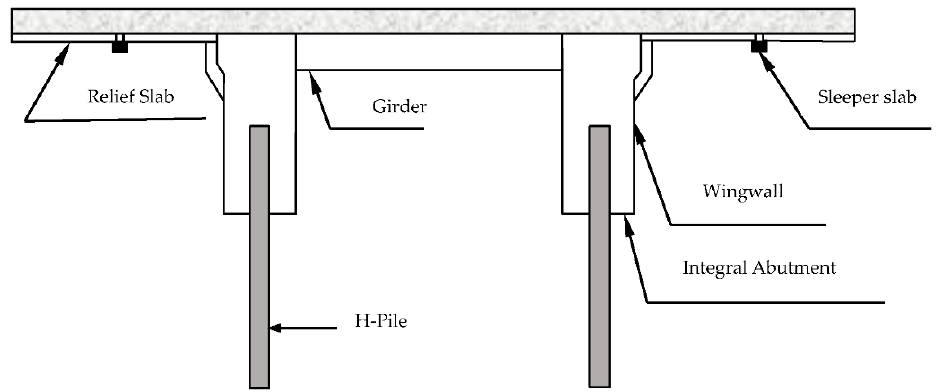
Figure A4. Schematic diagram of the integral bridge system with the sleeper slab.